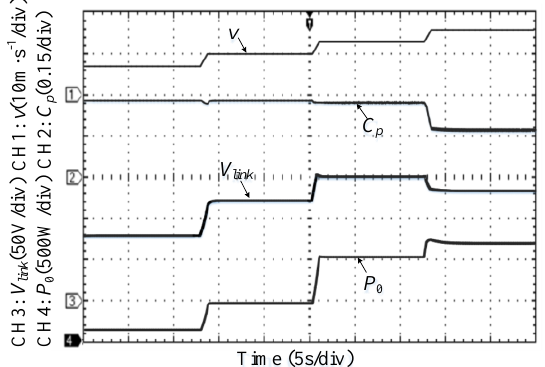
Figure 8. System performances under step changing wind profile.